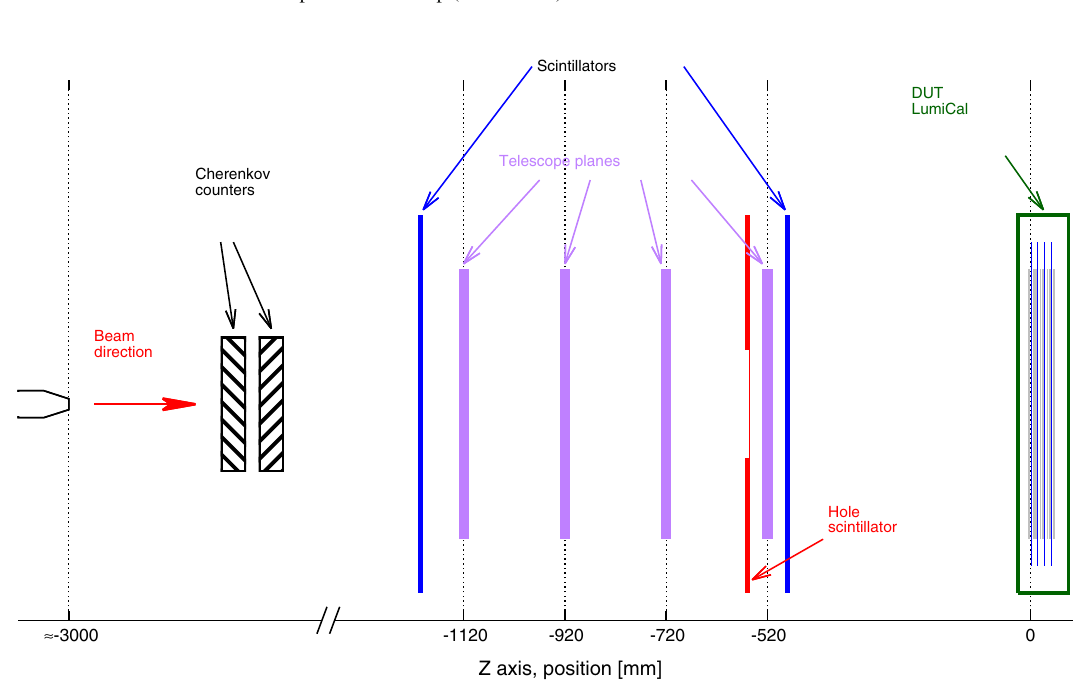
Fig. 8 Beam test area instrumentation geometry. Not to